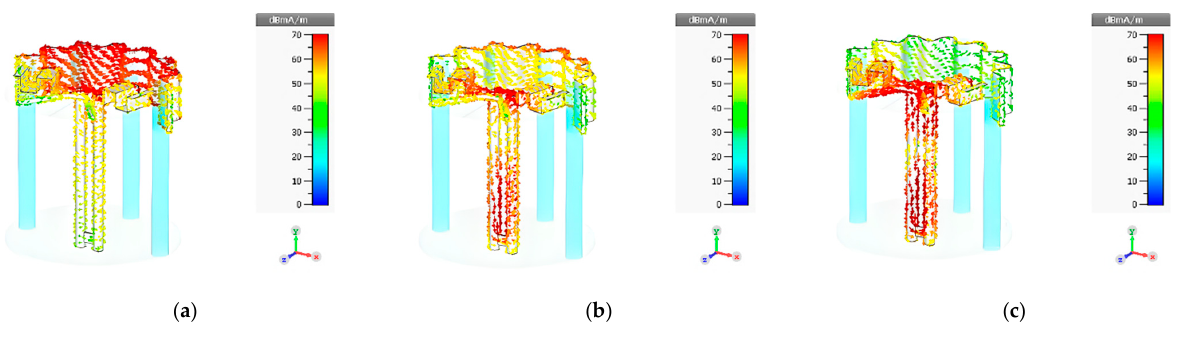
Figure 11. Simulated surface current distribution of the proposed portable wideband directional antenna scheme at: ( a ) 470 MHz, ( b ) 680 MHz, and ( c ) 890 MHz.